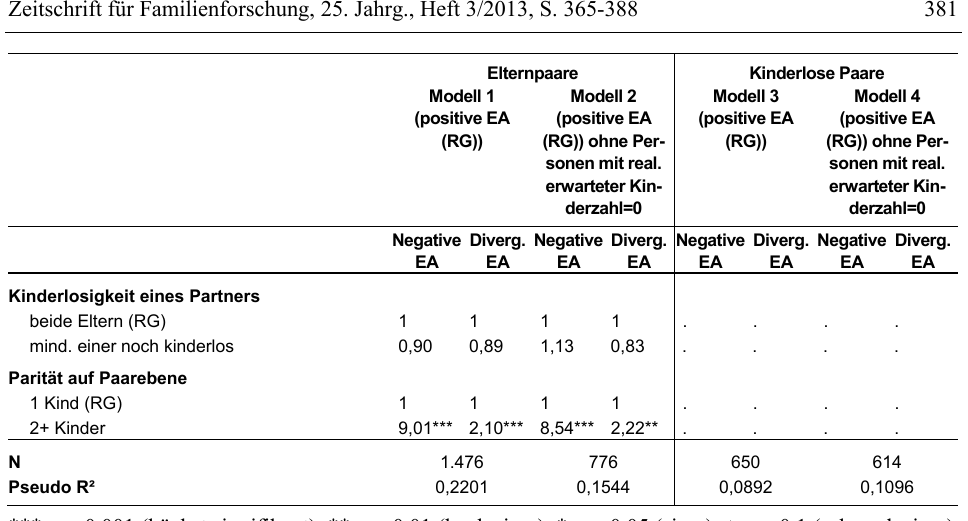
5.2 Einfluss der Kontrollvariablen auf die Elternschaftsabsichten von